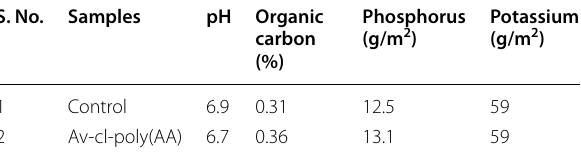
Table 3 Analysis of soil samples containing biodegraded Av-cl-